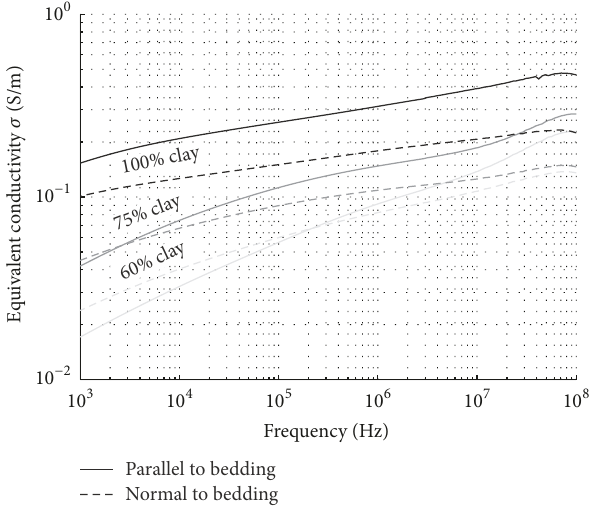
Figure 11: Dielectric response of the three brine-saturated artificial shale samples with clay contents of 60, 75, and 100 per cent.